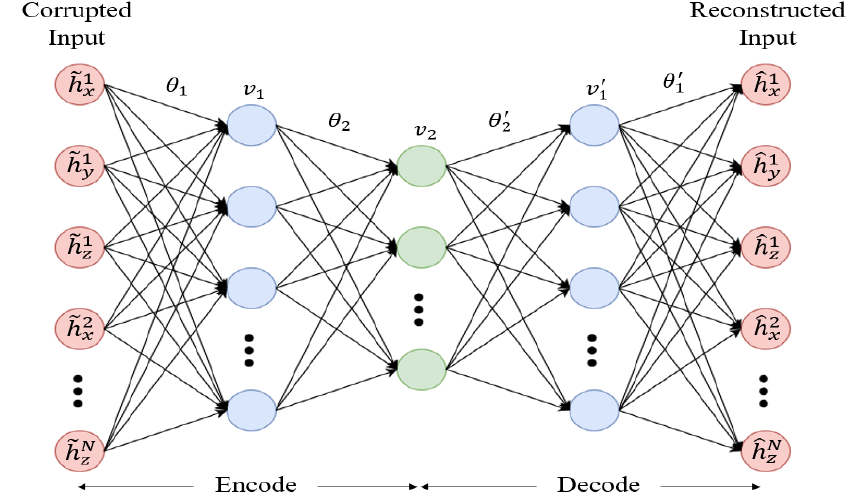
Figure 1. Denoising autoencoder architecture with corrupted 3D CSI as the feature vector